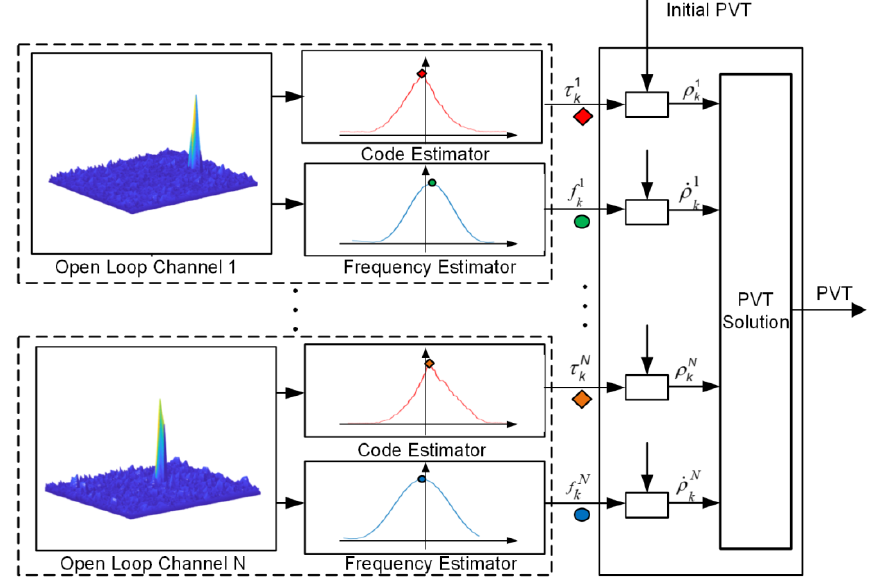
Figure 1. Diagram of conventional open loop tracking and position, velocity and time (PVT) solution.